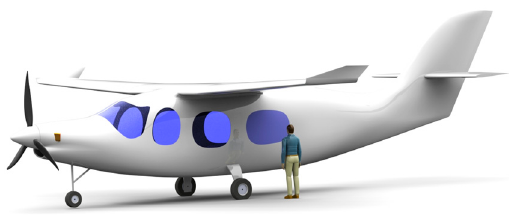
Figure 1. Conceptual prototype skydiver and freight role aircraft by Air Ute Pty Ltd. with conventional turboprop propulsion system.